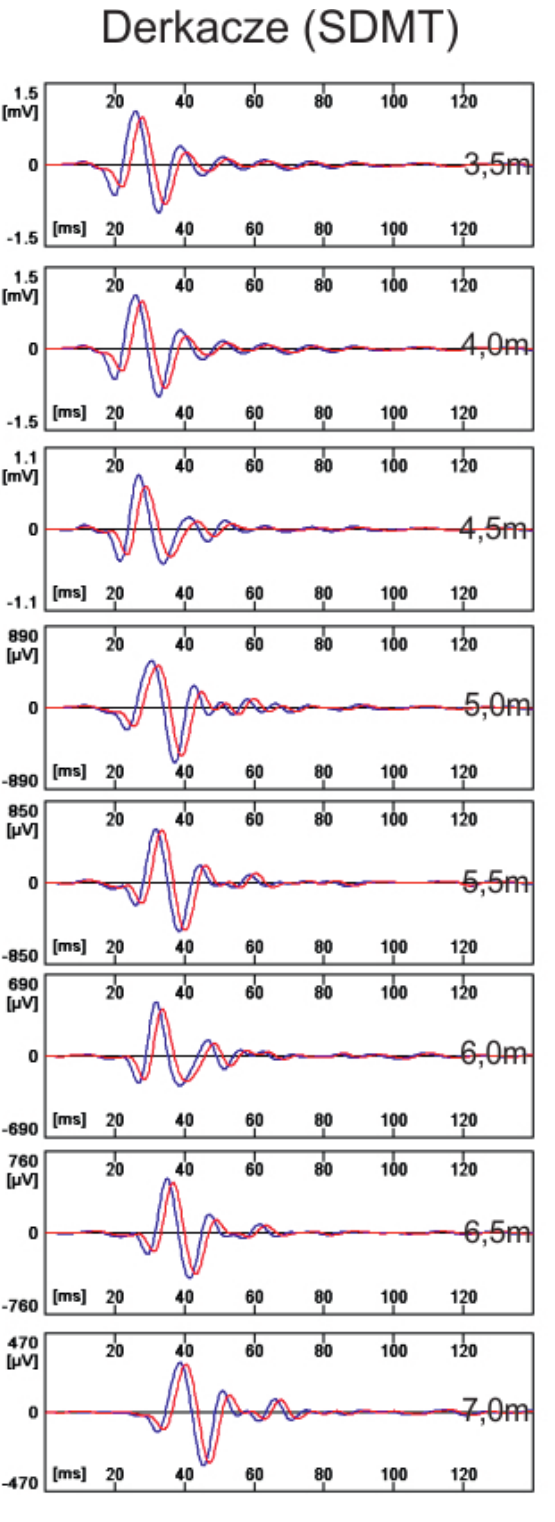
Figure 2: The example of a set of shear wave readings for SDMT and